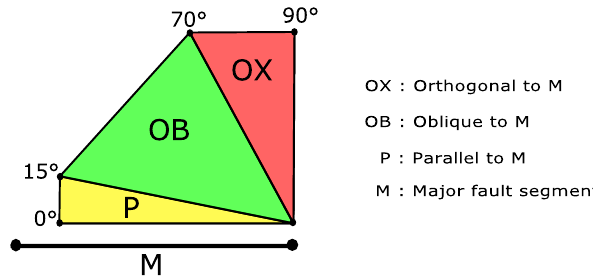
Figure 2. Segmentation typologies (TYP) used to define the identity code of each segment